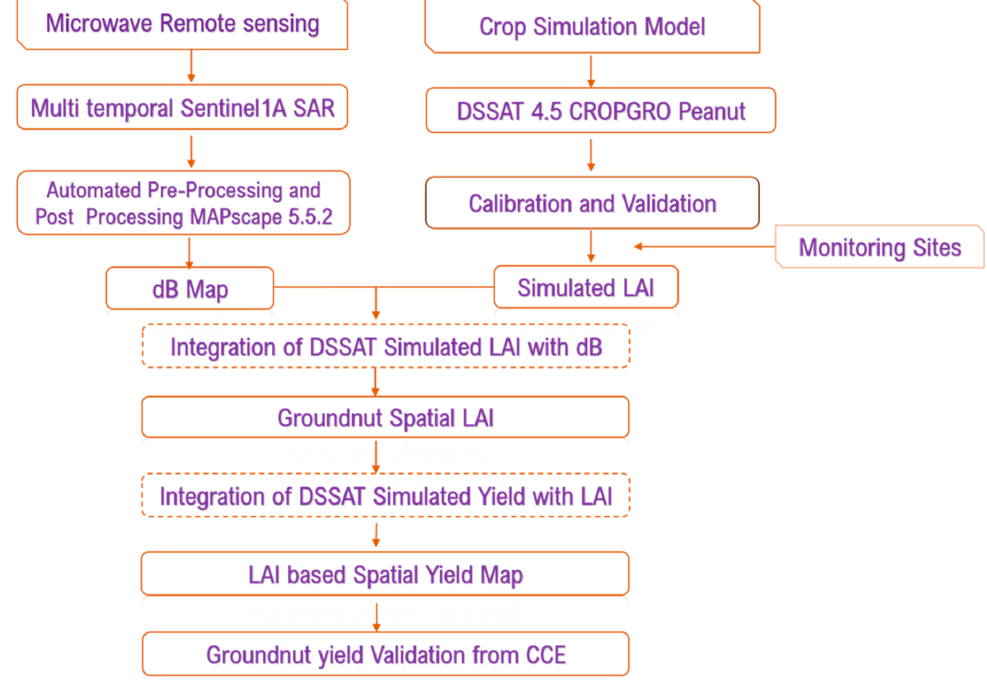
Figure 4. Integration of remote sensing and DSSAT simulation model for yield estimation.